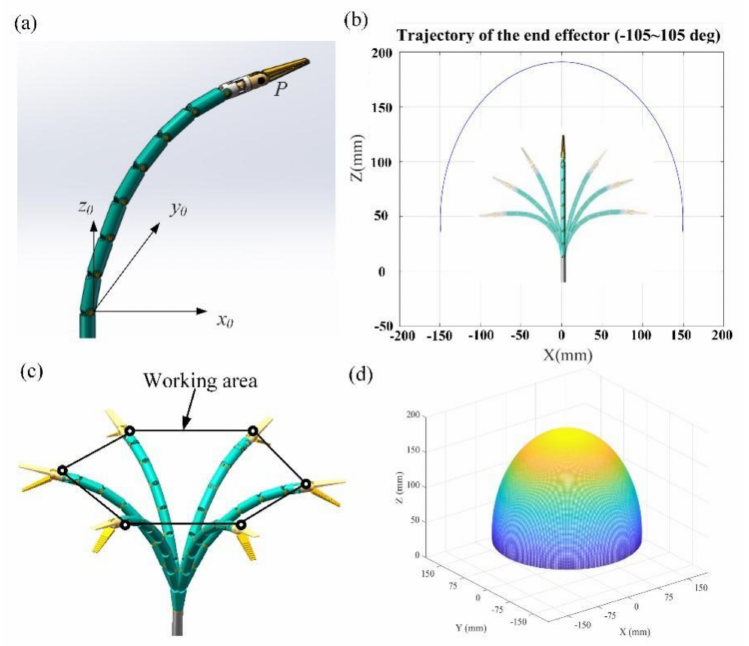
Figure 4. Workspace of the flexible instrument: ( a ) instrument coordinate system; ( b ) instrument plane motion trajectory; ( c ) instrument workspace trajectory; ( d ) instrument